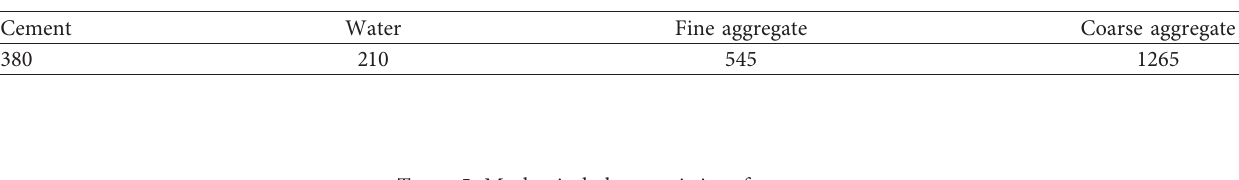
Figure 10: Dog-bone specimen and loading apparatus [34]. Table 4: Mix proportion of concrete (kg/m 3 ).